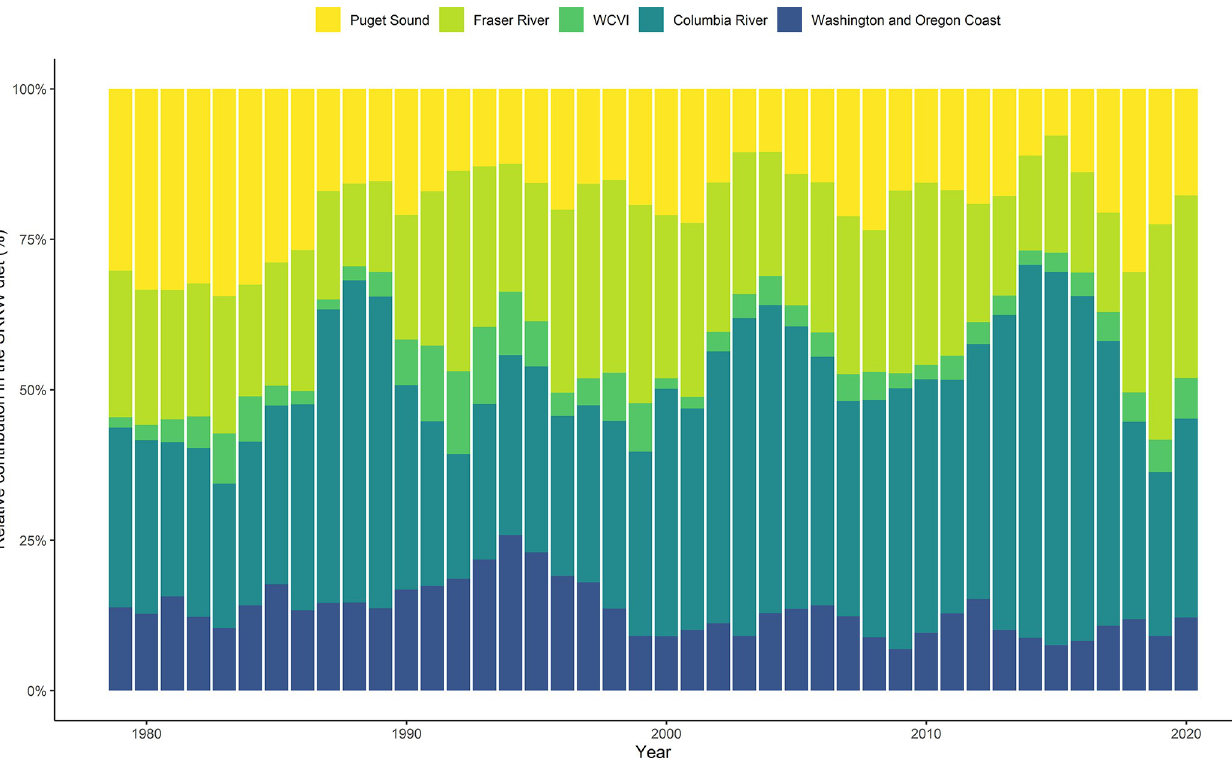
Fig 7. Estimated relative proportion (in %) of different stocks in the predicted SRKW diet from 1979 to 2020. For clarity, the stocks were split into five geographical areas: Puget Sound (NKF, NKS, PSY, PSN, PSF, SNO, SKG, STL), Fraser River (FS2, FS3, FSS, FSO, FCF, FHF, LGS, MGS), WCVI (WVN, WVH), Columbia River (URB, SUM, MCB, CWS, CWF, WSH, LYF, SPR, BON), and Washington Coast and Oregon Coast (WCH, WCN,